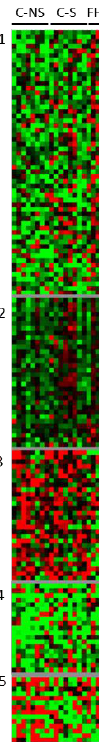
Figure 4. Proteins differentially expressed with supplementation ( n = 150). Unsupervised Bayesian clustering for the four groups ( n = 8/group).